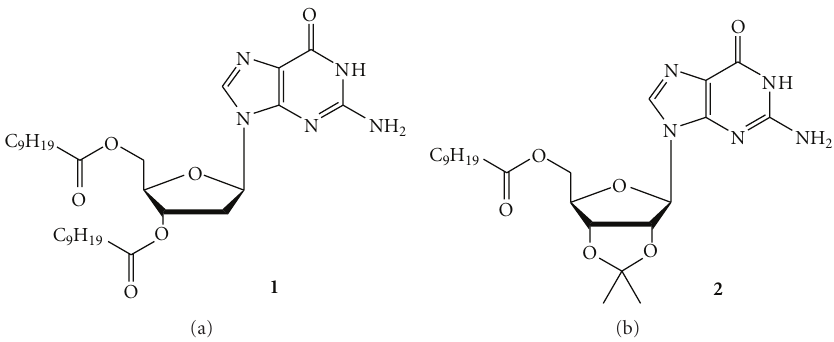
Figure 2: Structures of the two guanosine derivatives 1 and 2 .